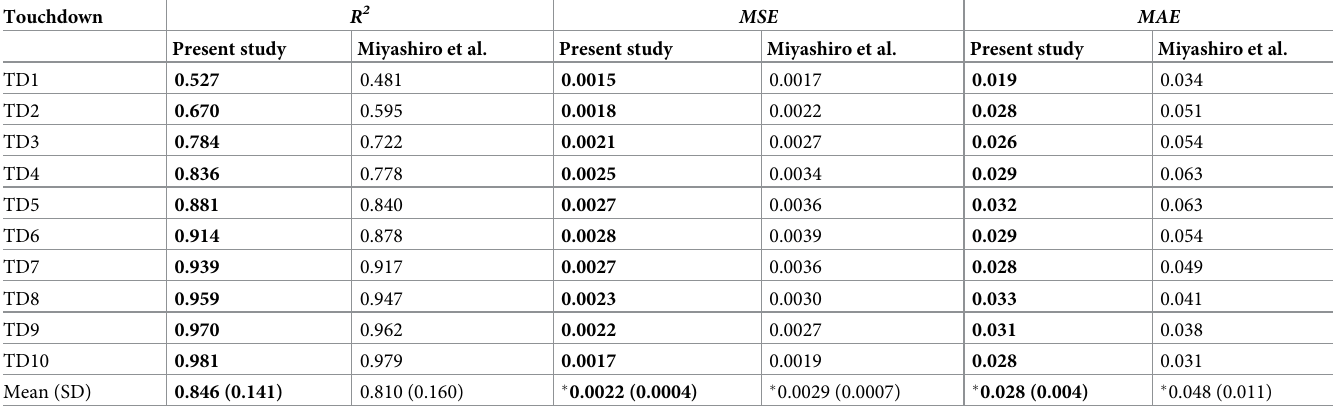
Table 1. Comparison of goodness of fit and generalization in each equation between the present study model and Miyashiro model. Touchdown R 2 MSE MAE Present study Miyashiro et al. Present study Miyashiro et al. Present study Miyashiro et